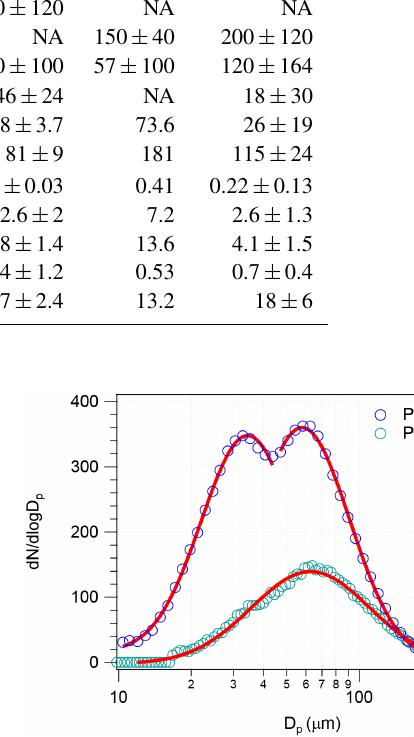
Figure 8. Mean PNSD during clear sky conditions measured with DMA 3081 during the campaign in 2015 (blue circles) and 2016 (turquoise circles). The red lines are lognormal fits with geometric mean diameters of 34 and 58nm for the bimodal distribution ob- served in 2015 and 63nm for